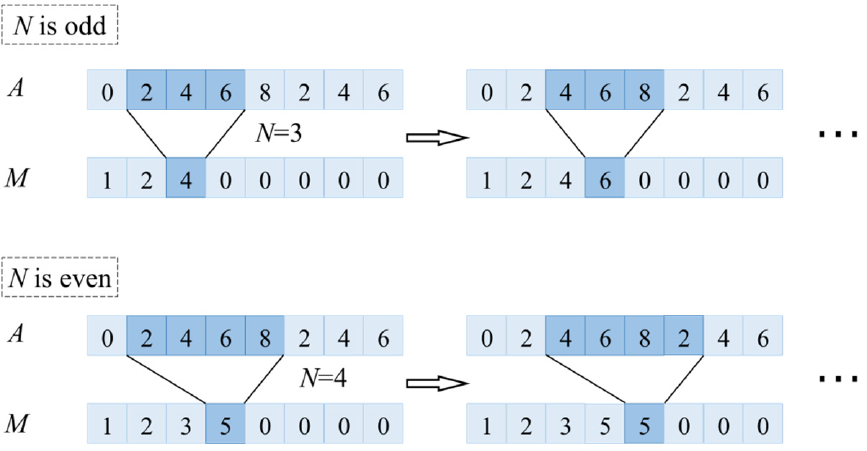
Figure A1. The process of AF.